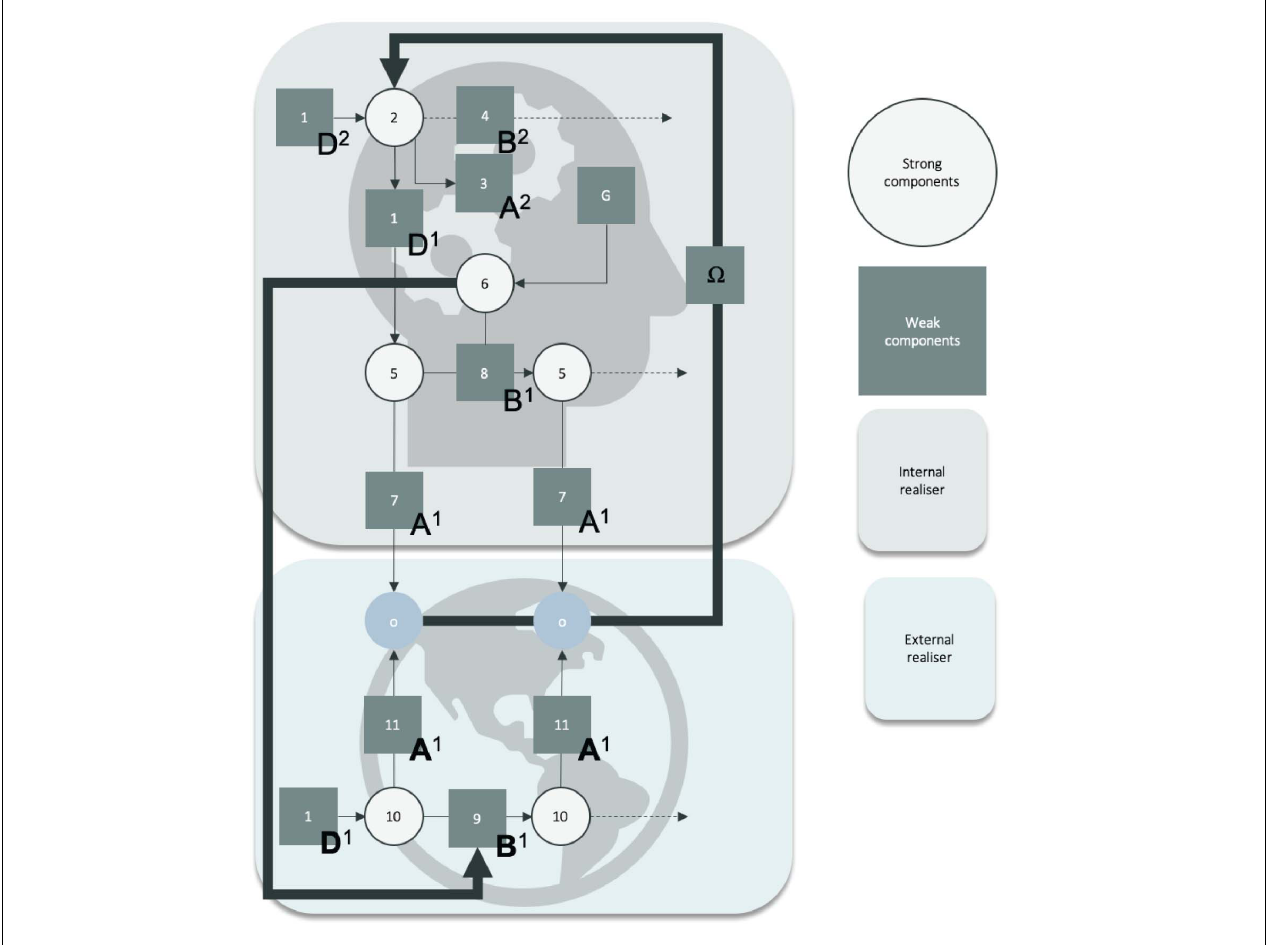
FIGURE 2 | Heuristic description of the generative model of the niche and of the agent. This schematic should be read as a heuristic “formal flowchart” of the biasing relation between priors and likelihood in generative model, rather than as a standard (probabilistic graphical) generative model. Weak scripts correspond to the knowledge about event types and their relation to sensory data available to the agent. Computationally, these correspond to priors and likelihoods (denoted as squares 1, 3, 4, 8, 7, 11, 9) that are combined to infer sequences of hidden states and the action policy (denoted as open circles 2, 5, 6, 10). Note that, for instance, “D1” in the bottom portion of the schematic is not the same as “D1” in the top section since the former is an attribute of the generative process, and the latter is an attribute of the generative model. We use the notion “D1” in both cases to help the unfamiliar reader to visualize the mirroring relation between the generative process and